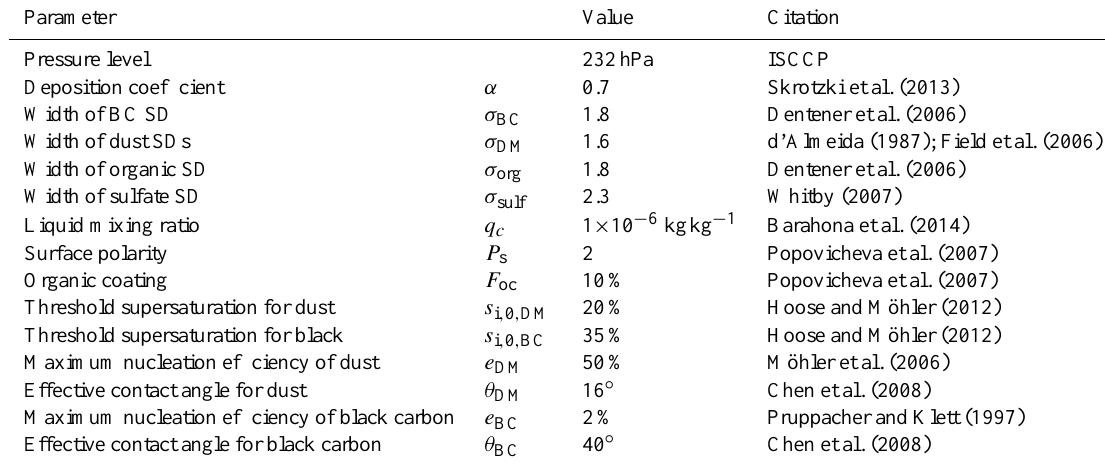
Table 1. Adjustable parameters for ABN15 simulations. Parameter Value Citation Pressure level 232hPa ISCCP Deposition coefficient α 0.7 Skrotzki et al. (2013) Width of BC SD σ BC 1.8 Dentener et al. (2006) Width of dust SDs σ DM 1.6 d’Almeida (1987); Field et al. (2006) Width of organic SD σ org Width of sulfate SD Liquid mixing ratio Surface polarity Organic coating F oc Threshold supersaturation for dust s i , 0 , DM 20% Hoose and Möhler (2012) Threshold supersaturation for black s i , 0 , BC 35% Maximum nucleation efficiency of